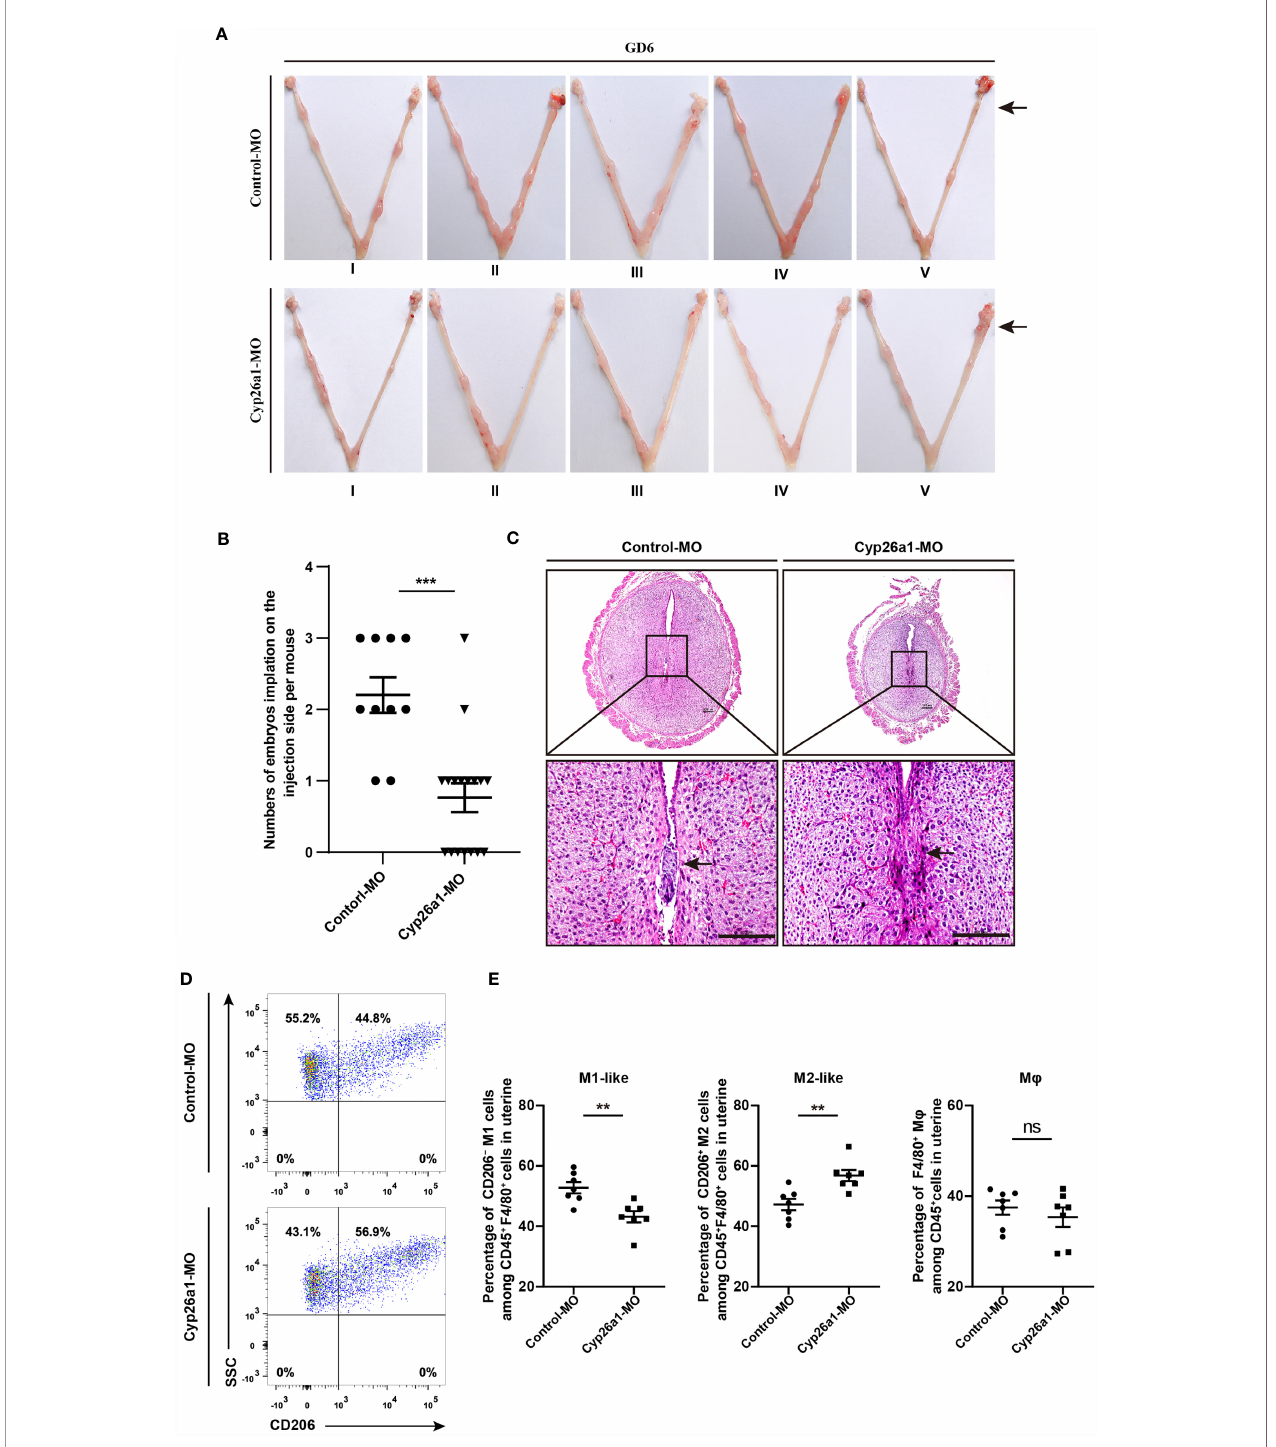
FIGURE 3 | Knockdown of CYP26A1 in uterus affects embryo implantation and the balance of uterine M1-like and M2-like macrophages. (A) Representative macroscopic views of the uterus injected with Control-MO or Cyp26a1-MO. Arrows indicates the injection site. (B) Statistics of embryo implantation sites on the MO-injection side (Control-MO, n=10; Cyp26a1-MO, n=17). (C) H&E staining of tissue sections at the implantation sites. Scale bar, 100 µm. Arrows indicates the implantation sites. (D, E) FCM analysis of the ratio of uterine M1-like and M2-like macrophages on the MO-injection side (n=7). Error bars represent means ± SEM; two-tailed unpaired t-test, ns, not signi fi cant, **P < 0.01 or ***P <